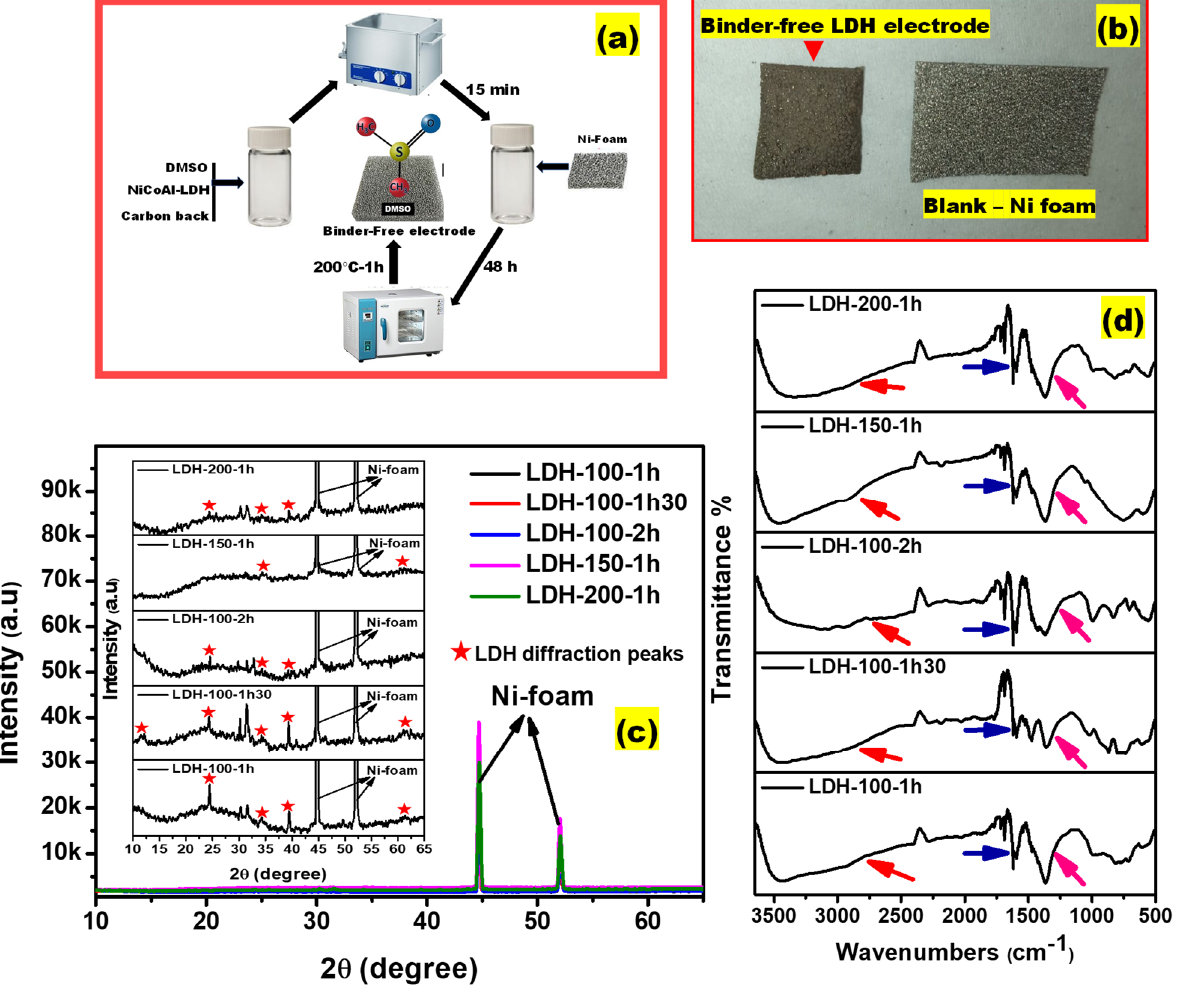
Figure 2. ( a ) Schematic illustration of the fabrication process of binder-free LDH electrodes; ( b ) the image of the as-fabricated binder-free LDH electrode; ( c ) XRD patterns of the LDH-100-1h, LDH-100-1h30, LDH-100-2h, LDH-150-1h, and LDH-200-1h electrodes; and ( d ) FTIR spectra of the LDH-100-1h, LDH-100-1h30, LDH-100-2h, LDH-150-1h, and LDH-200-1h electrodes.